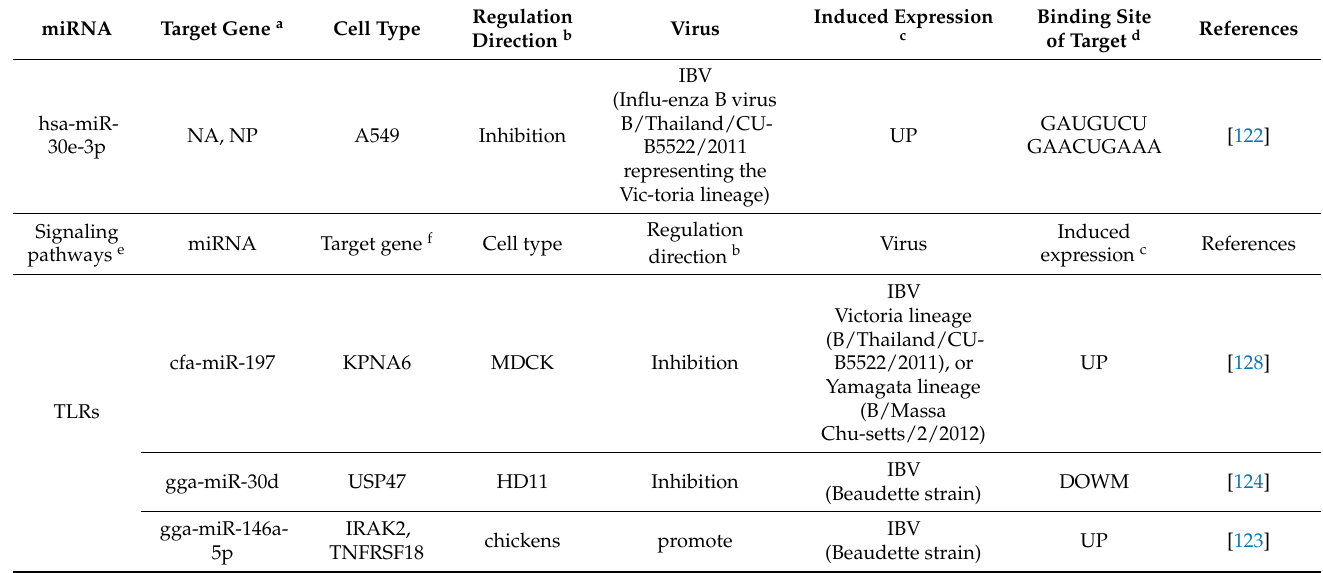
Table 4. Regulation of miRNA on replication of influenza viruses other than influenza A